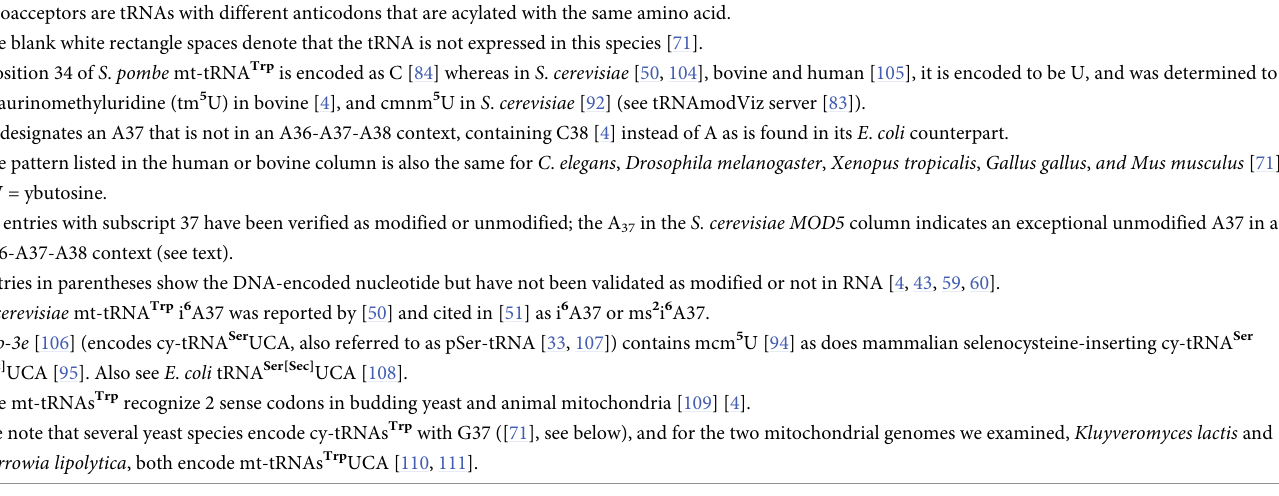
prokaryote-type IPTase [25–29]. Complementation is often shown using tRNA-mediated sup- pression (TMS) which reflects decoding of an mRNA premature stop codon by a suppressor- tRNA Tyr UUA that requires i 6 A37 for activity. A comparable TMS system in S . pombe is medi- ated by suppressor-tRNA Ser UCA [30–33]. In both systems, TMS can be readily monitored by a red-white colony assay. Full length TRIT1 (1–467) cloned from human cDNA is active for TMS in S . cerevisiae [25]. Human TRIT1 also complements tRNA Ser UCA-i 6 A37-mediated TMS in S . pombe although the TRIT1-R323Q mutation associated with neurodevelopmental disease is largely inactive in the same assay [14].